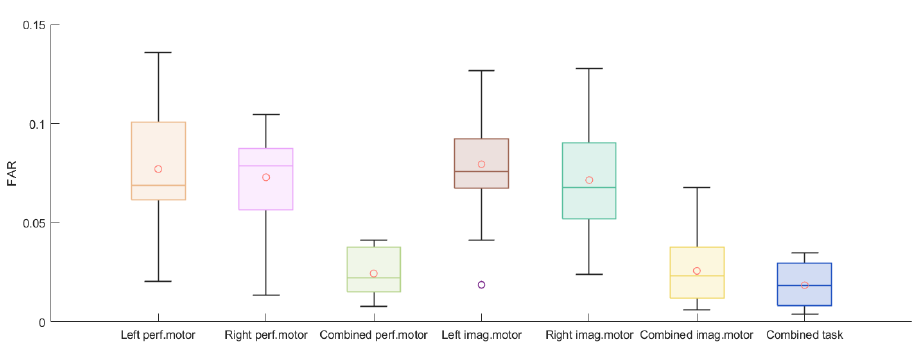
Figure 9. Boxplots of 15 subjects’ averaged FAR for 5-fold cross-validation for left performed motor, right performed motor, combined performed motor, left imagined motor, right imagined motor, combined imagined motor, and combined